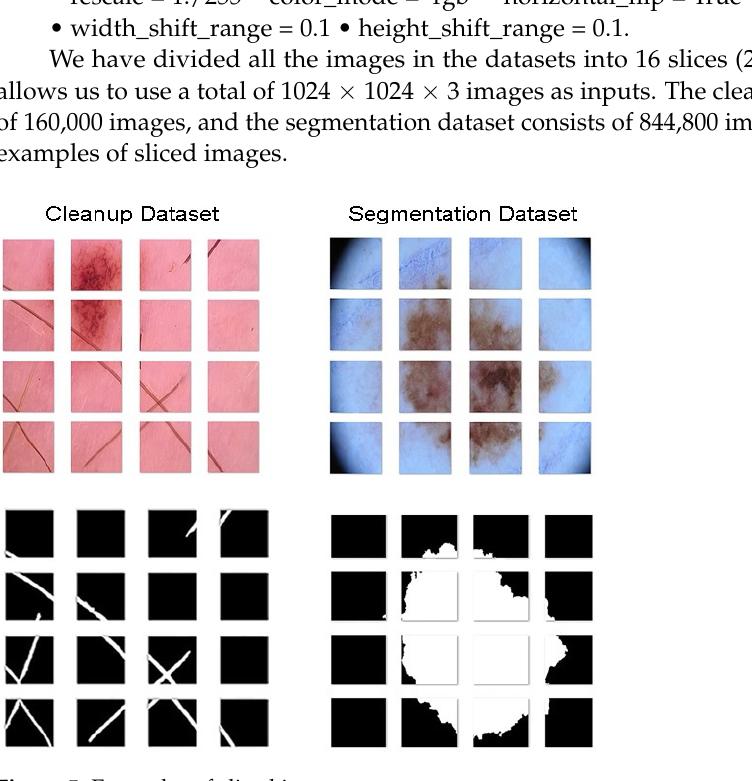
Figure 5. Examples of sliced